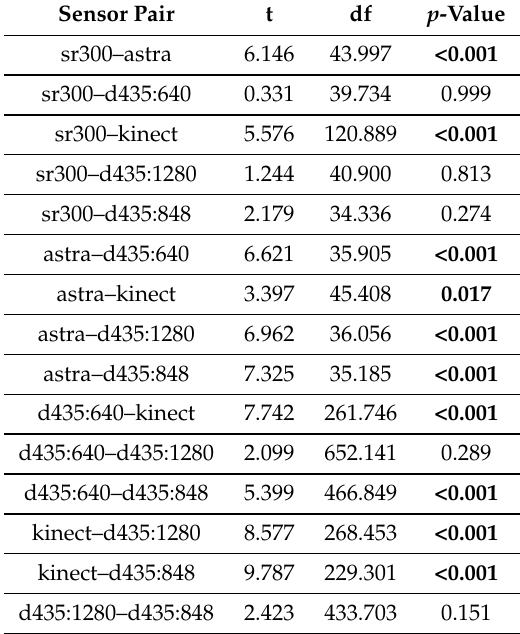
Table 6. Games–Howell test results for large ball size estimation. Significant results are